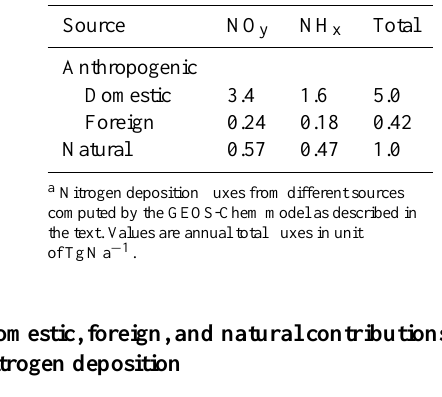
Fig. 9. Annual total nitrogen deposition fluxes. Values are GEOS- Chem averages for 2006-2008.